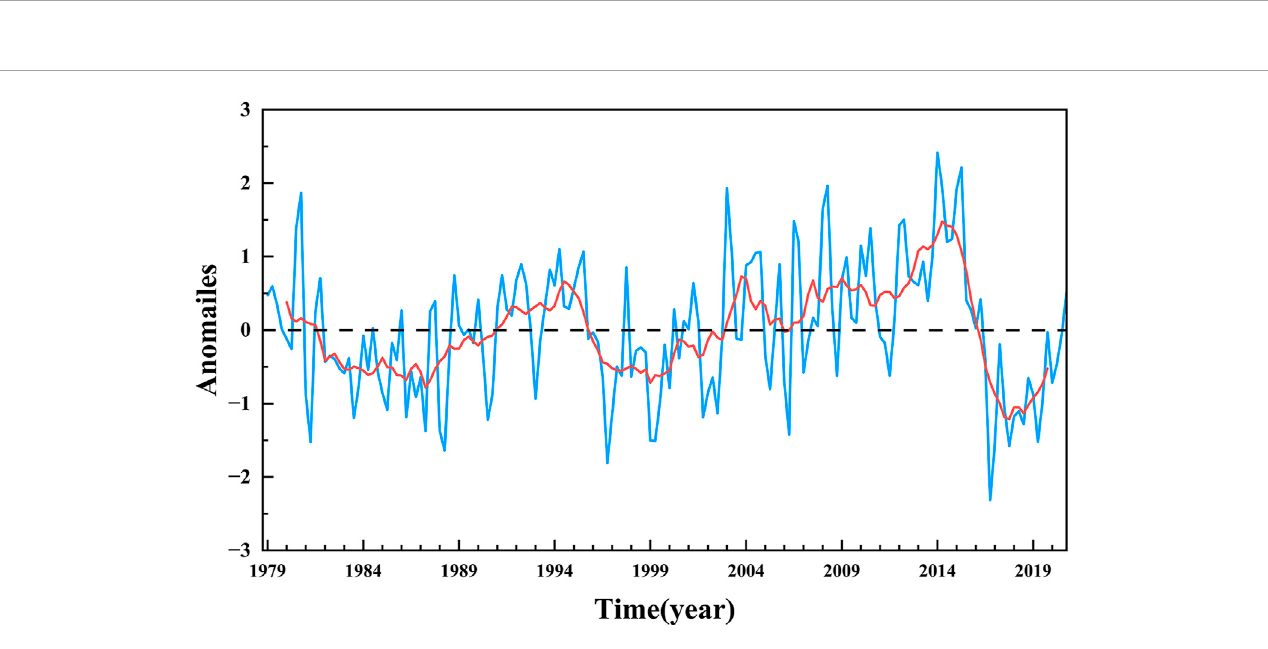
FIGURE 2 TimeseriesofWeddellSeaaveragedSICanomaly1979 – 2020(unit:%).Thebluelinerepresentstheaveragedseasonalanomaly,andtheredlinedenotes the nine-season running average of the SIC